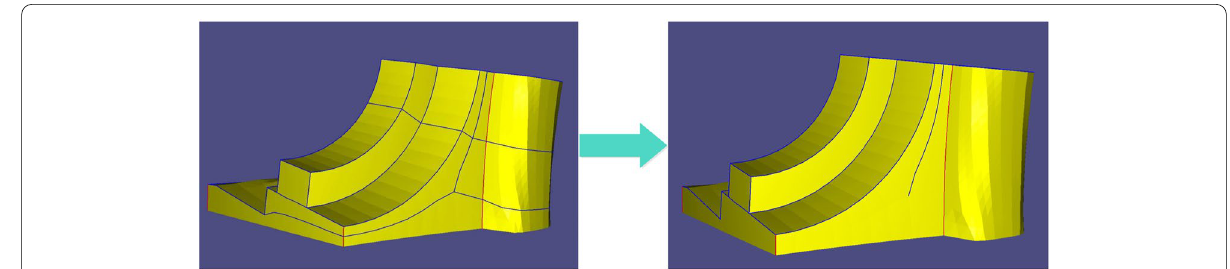
Fig. 8 Removing redundant connection edges of EPs